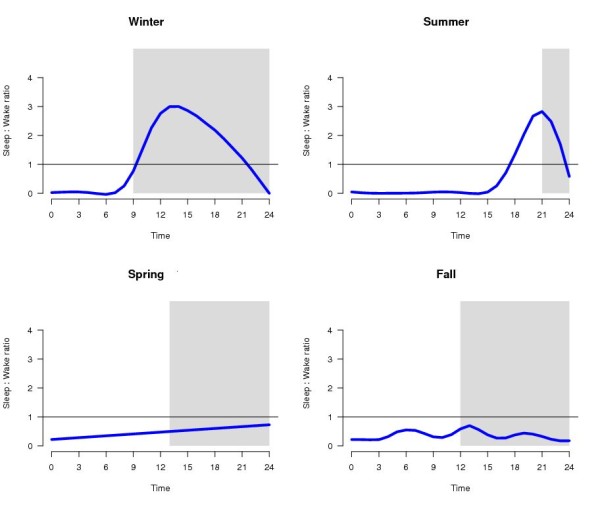
Sleep consolidation index for all seasons. Hourly average ratio of sleep bout length to wake bout length was calculated for birds during each season. The blue line represents a smoothed curve through these data. The time during which the smoothed value of the ratio of sleep bout length to wake bout length exceeded 1.00 was used to define the "sleep consolidation index" for each season. In winter, hour 10 is first hour in which the ratio exceeds 1 and this ratio falls below 1 at hour 21, resulting in a sleep period of 11 hours. In summer, the sleep period begins at hour 18 and ends at hour 23. It is noteworthy that this sleep period begins prior to the onset of darkness. A similar phenomenon can be observed in the sleep times plotted in Figure 2. There was no sleep consolidation during the migratory seasons, spring and fall.